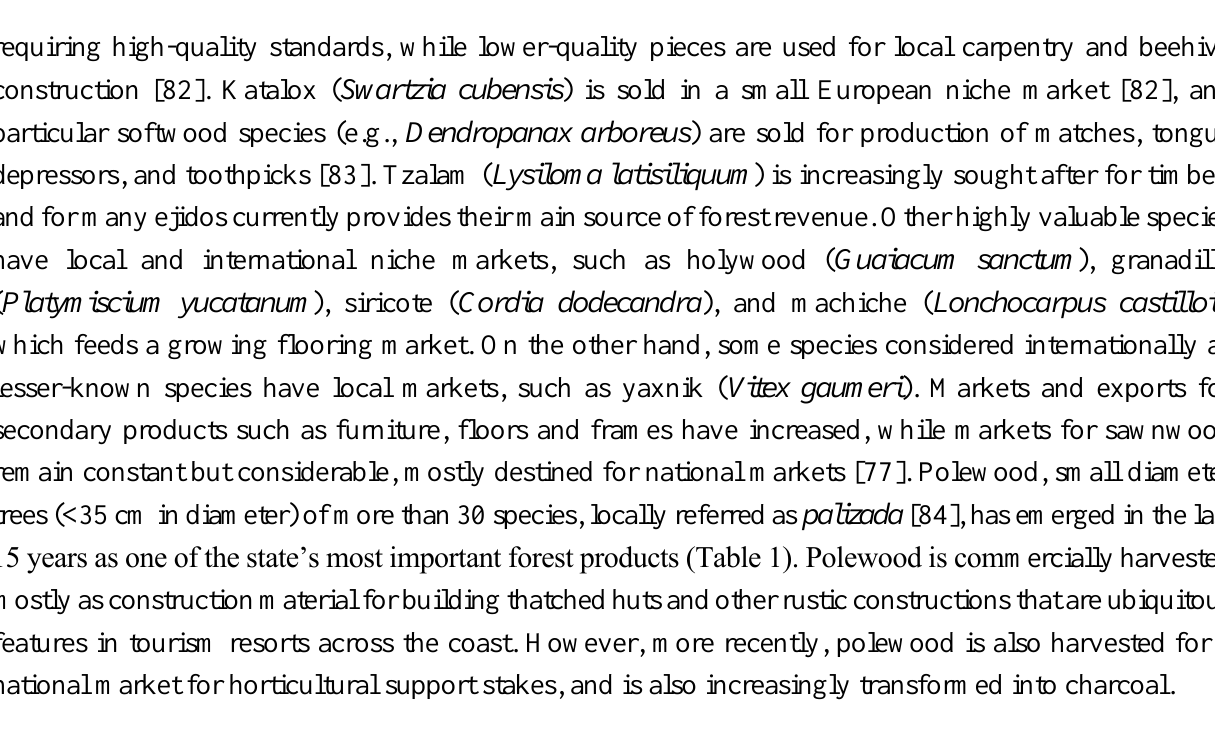
Table 1. Harvested timber volumes per species and harvested volumes as percentage of the authorized timber volumes per species in Quintana Roo, Mexico. Volumes per species are calculated as the average of the years 2012 and 2013